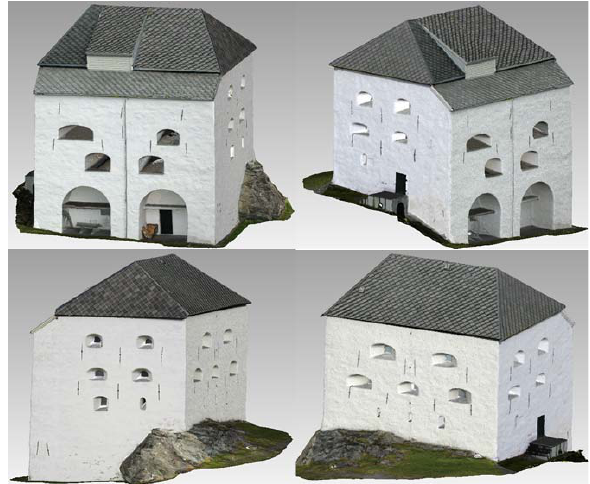
Figure 2. Different perspective views of the fortress building Kristiansten in Trondheim – Scanning by Riegl VZ-400, meshing and manual texture mapping with Geomagic